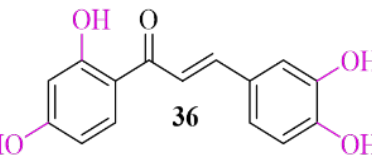
Figure 26. Chemical structure of butein ( 36 ).